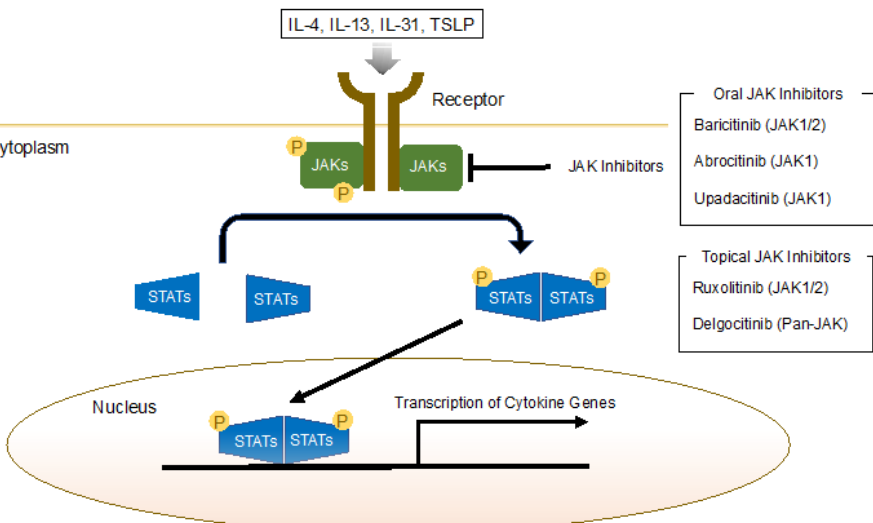
Figure 2. JAK–STAT signaling and oral/topical JAK inhibitors in atopic dermatitis. The JAK protein family (JAK1, JAK2, JAK3, and TYK2) mediates IL-4, IL-13, and IL-31 cytokine signaling via cognate receptors. Activation of JAKs results in the phosphorylation of downstream STAT proteins, followed by their nuclear translocation and activation of target genes. JAK inhibitors inhibit the activity of one or more JAKs, thereby interfering with the JAK–STAT signaling pathway. JAK, Janus kinase; STAT, signal transducer and activator of transcription; TYK2, tyrosine kinase 2; IL, interleukin.